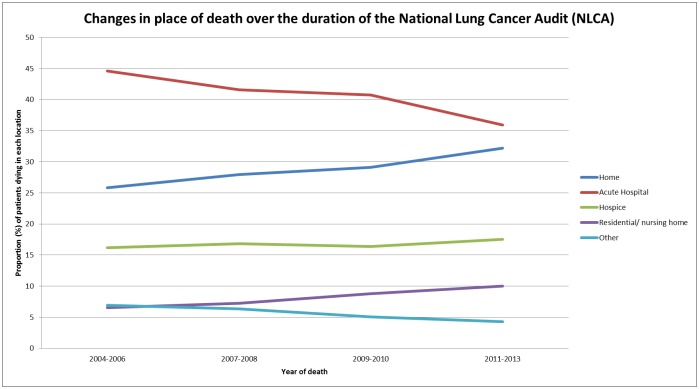
Changes in place of death between 2004 and 2013.